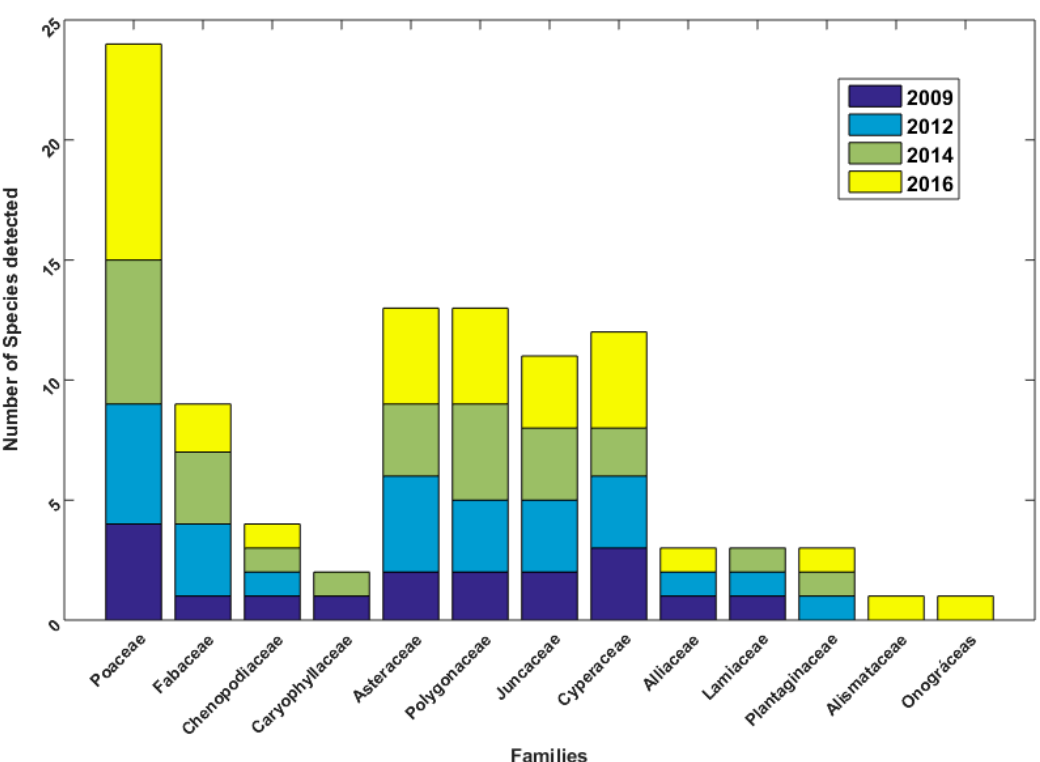
Figure 11. Specific richness by plant family detected in the samplings carried out during 2009 (blue), 2012 (light blue), 2014 (green), and 2016 (yellow).